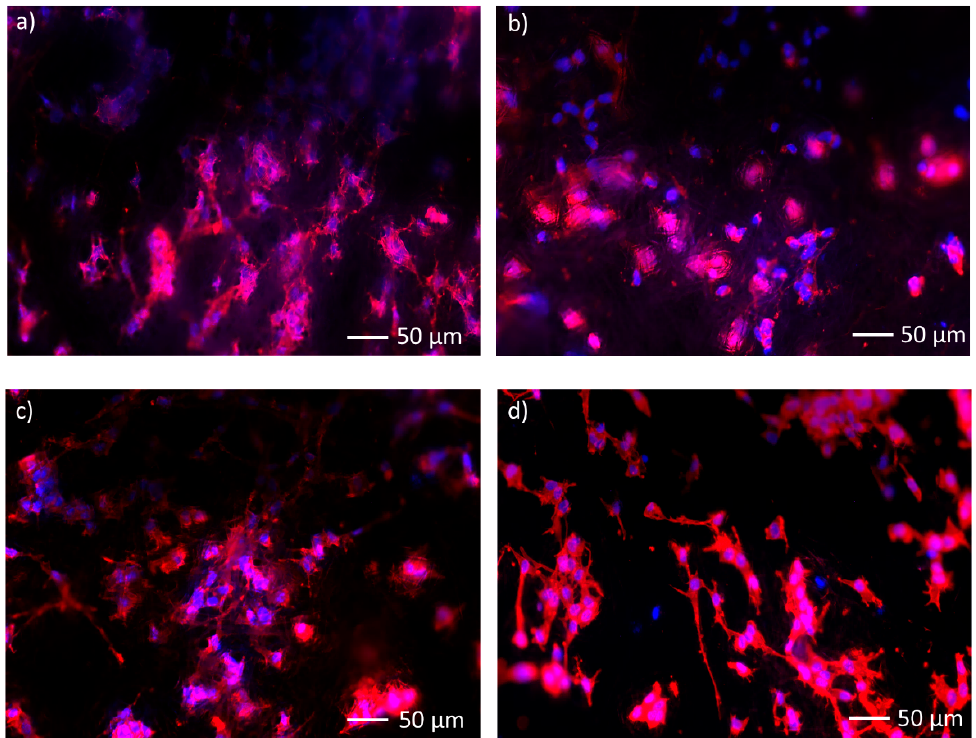
Figure 8. Fluorescence images of actin filaments (red) and cell nuclei (blue) for PCL ( a ), PCL_45S5 ( b ), PCL_BG10 ( c ), and PCL_BGZn ( d ) 7 days after the seeding.